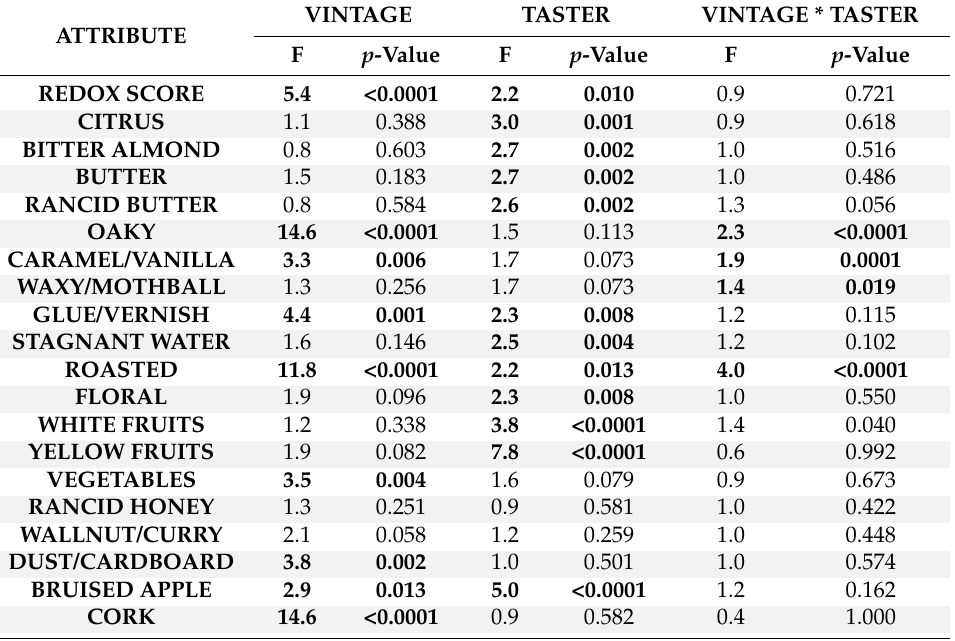
Table 1. Sensory attributes and ANOVA results. Significant P-values (5% level) are highlighted in bold